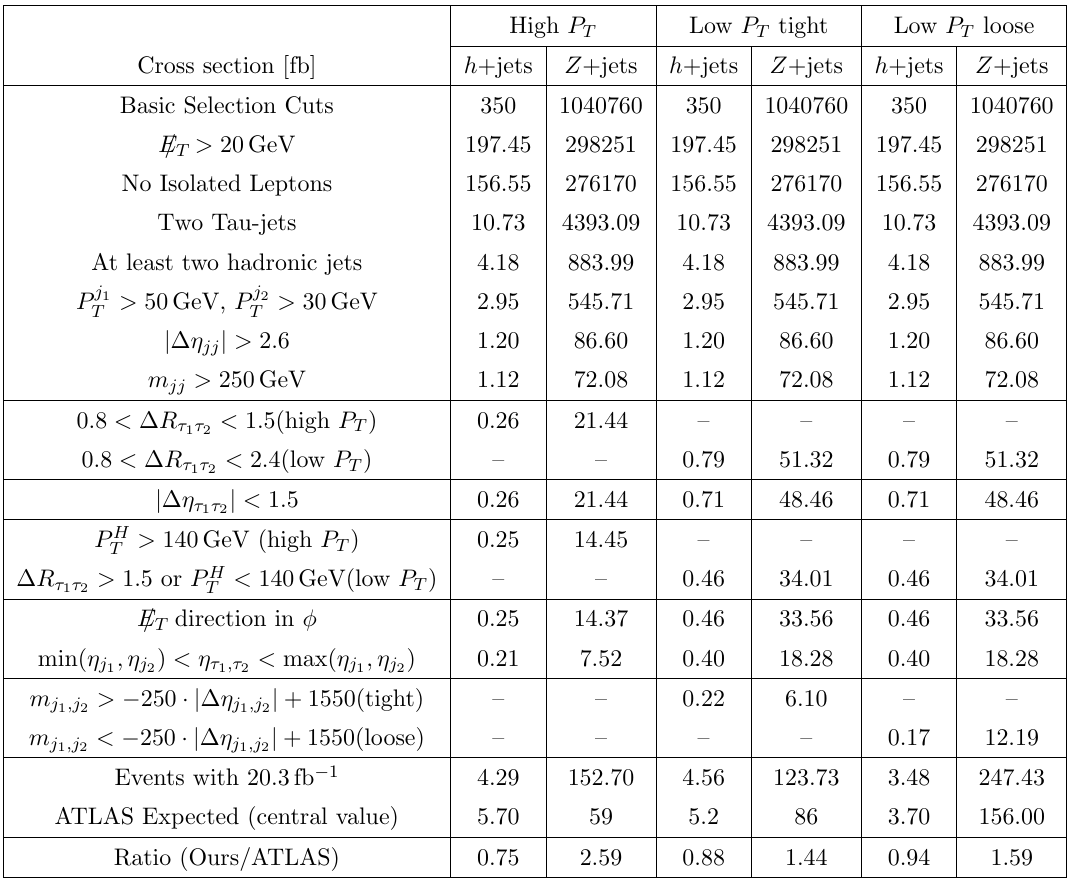
Table 2 . The cut-(cid:13)ow for the signal process h +jets (with h ! (cid:28) h (cid:28) h ) and the dominant SM background process of Z +jets (with Z ! (cid:28) h (cid:28) h ) in the VBF category for three di(cid:11)erent signal regions as de(cid:12)ned in ref. [47]. All cross-sections are shown in femtobarn units. Our results are shown at leading order for the 8 TeV LHC, whereas the ATLAS results include higher order corrections. For the SM backgrounds, we have only included the dominant process of Z +jets, while the ATLAS estimates shown also include fake backgrounds from multijet production, as well as other sub- dominant physics